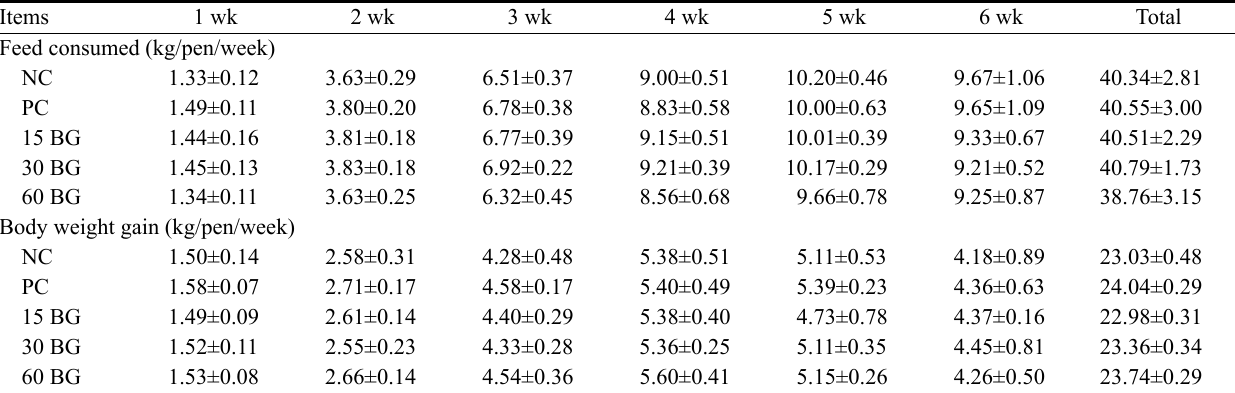
Table 2. Effect of β-glucan on the feed consumption and body weight gain of broiler